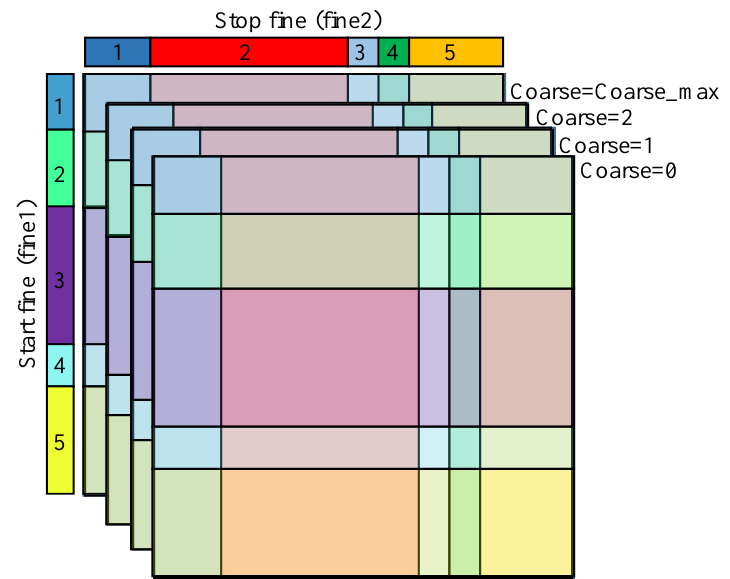
Figure 7. Three-dimension code density histogram of an asynchronous TDC with five-bin fine TDCs, the Stop and Start fine bin numbers are respectively represented on x and y, whereas the Coarse value is represented on z.